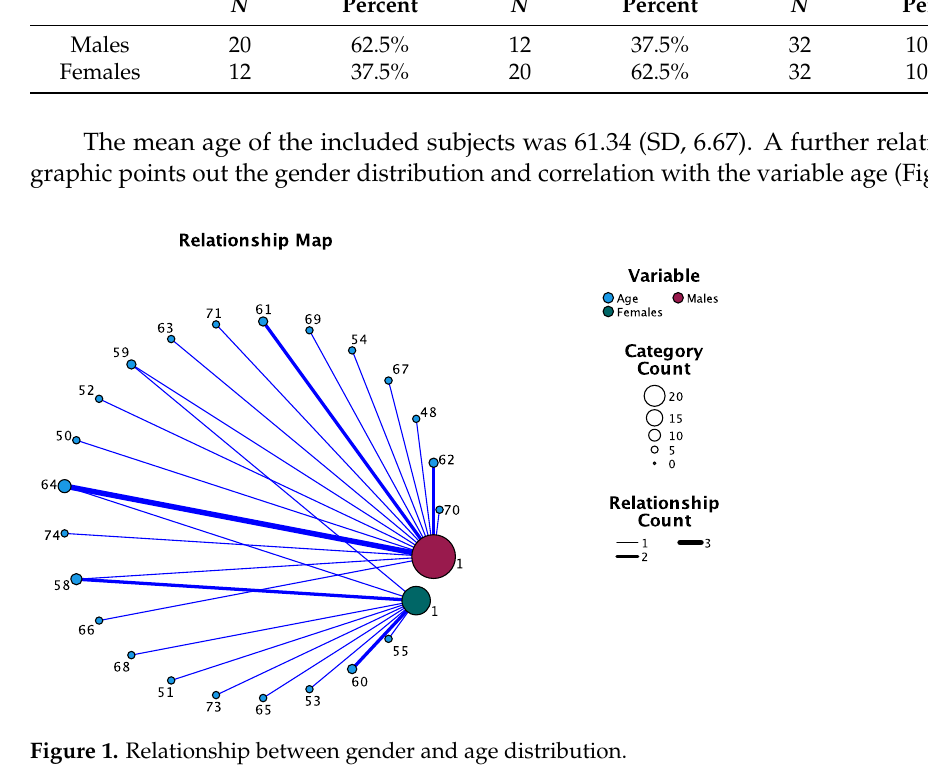
Figure 1. Relationship between gender and age distribution.